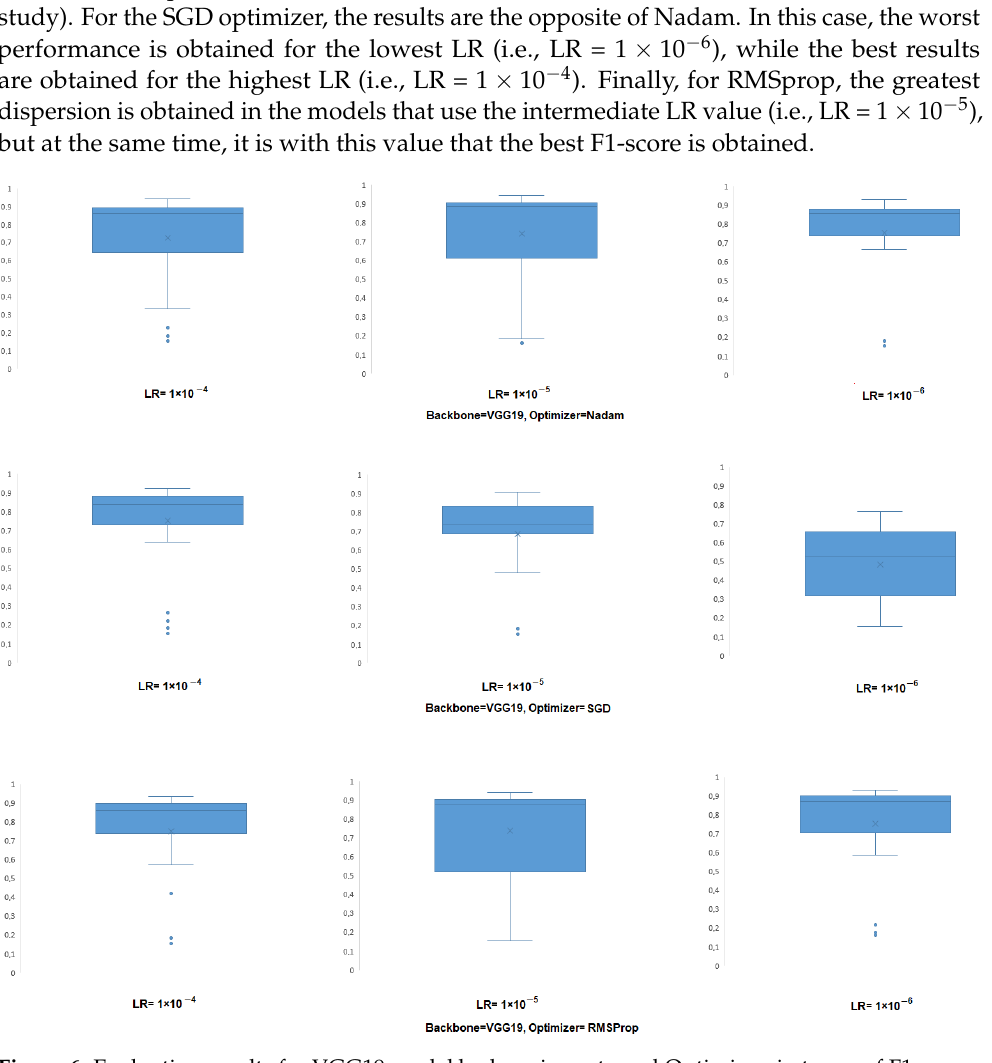
Figure 6. Evaluation results for VGG19 model by learning rate and Optimizer, in terms of